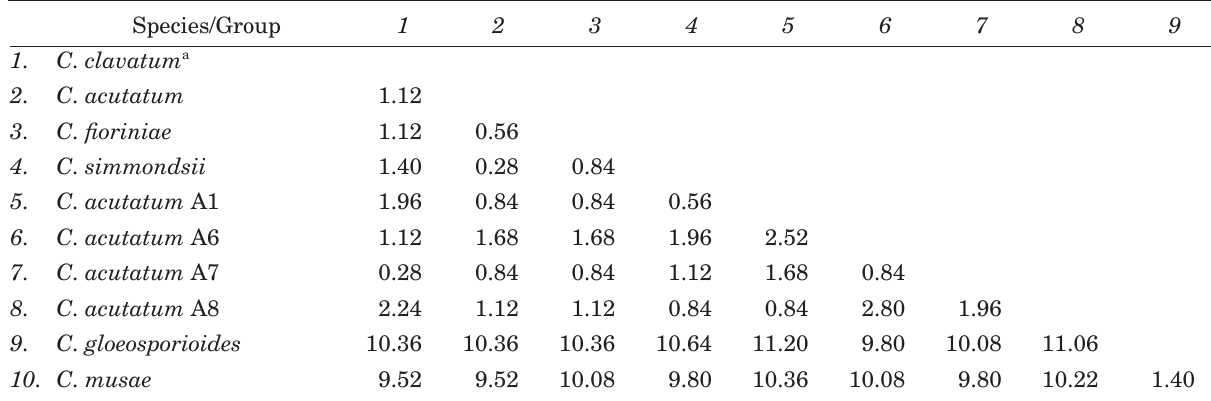
Table 3. Average pairwise percent sequence divergence among Colletotrichum spp. based on 109 nucleotide sequences of the ITS-rDNA region.